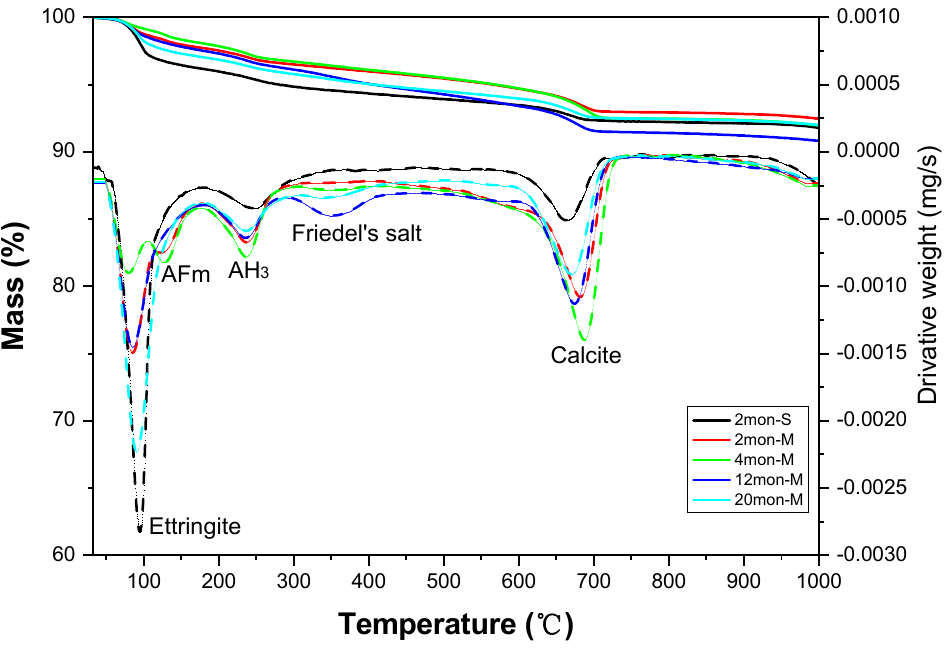
Figure 7. TGA patterns of CSA concrete samples after 2, 4, 12, and 20 months of marine tidal exposure. Table 6. Mass losses of hydration phases formed in the selected samples after marine tidal exposure. Mass loss (wt.%)